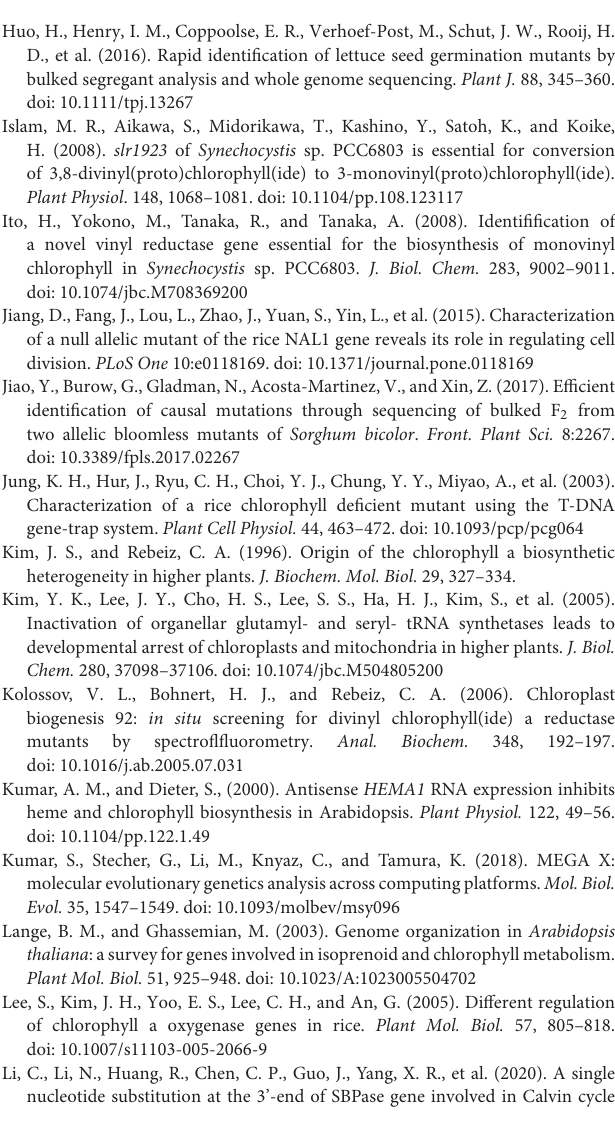
Supplementary Table S1 | Localization of chromosomal loci related to the pale green trait. Supplementary Table S2 | Primer sequences of SSR markers and INDEL markers. Supplementary Table S3 | Prediction of candidate genes within the gene-mapped region on chromosome A10. Supplementary Table S4 | Detection of SNP variations in the candidate region between “FT” and pem1 . Supplementary Table S5 | Primer sequences used for clone sequencing. Supplementary Table S6 | Primer sequences for qRT-PCR. Supplementary Table S7 | The TargetP result of BrDVR. Supplementary Table S8 | The ChloroP result of